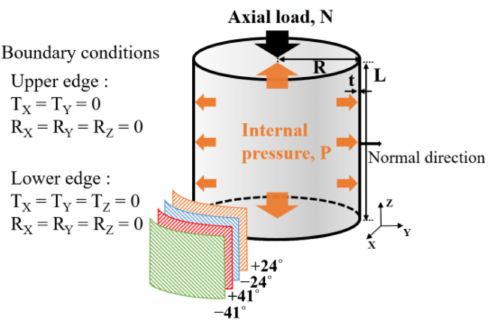
Figure 2. Schematic diagram of the thin-walled composite cylinder.